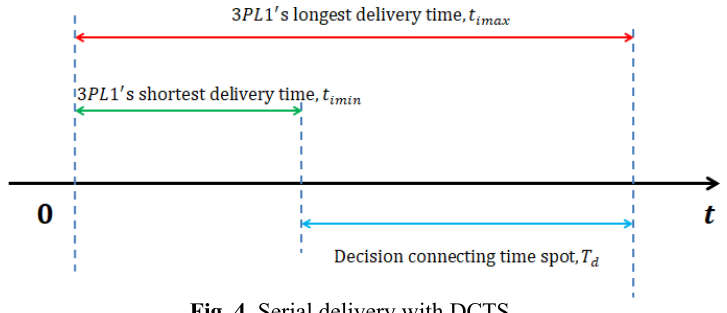
Fig. 4. Serial delivery with DCTS